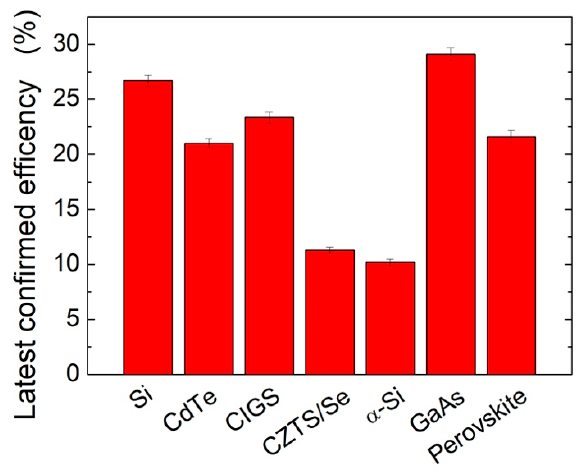
Figure 1. Efficiency of different materials in single-junction solar cells.